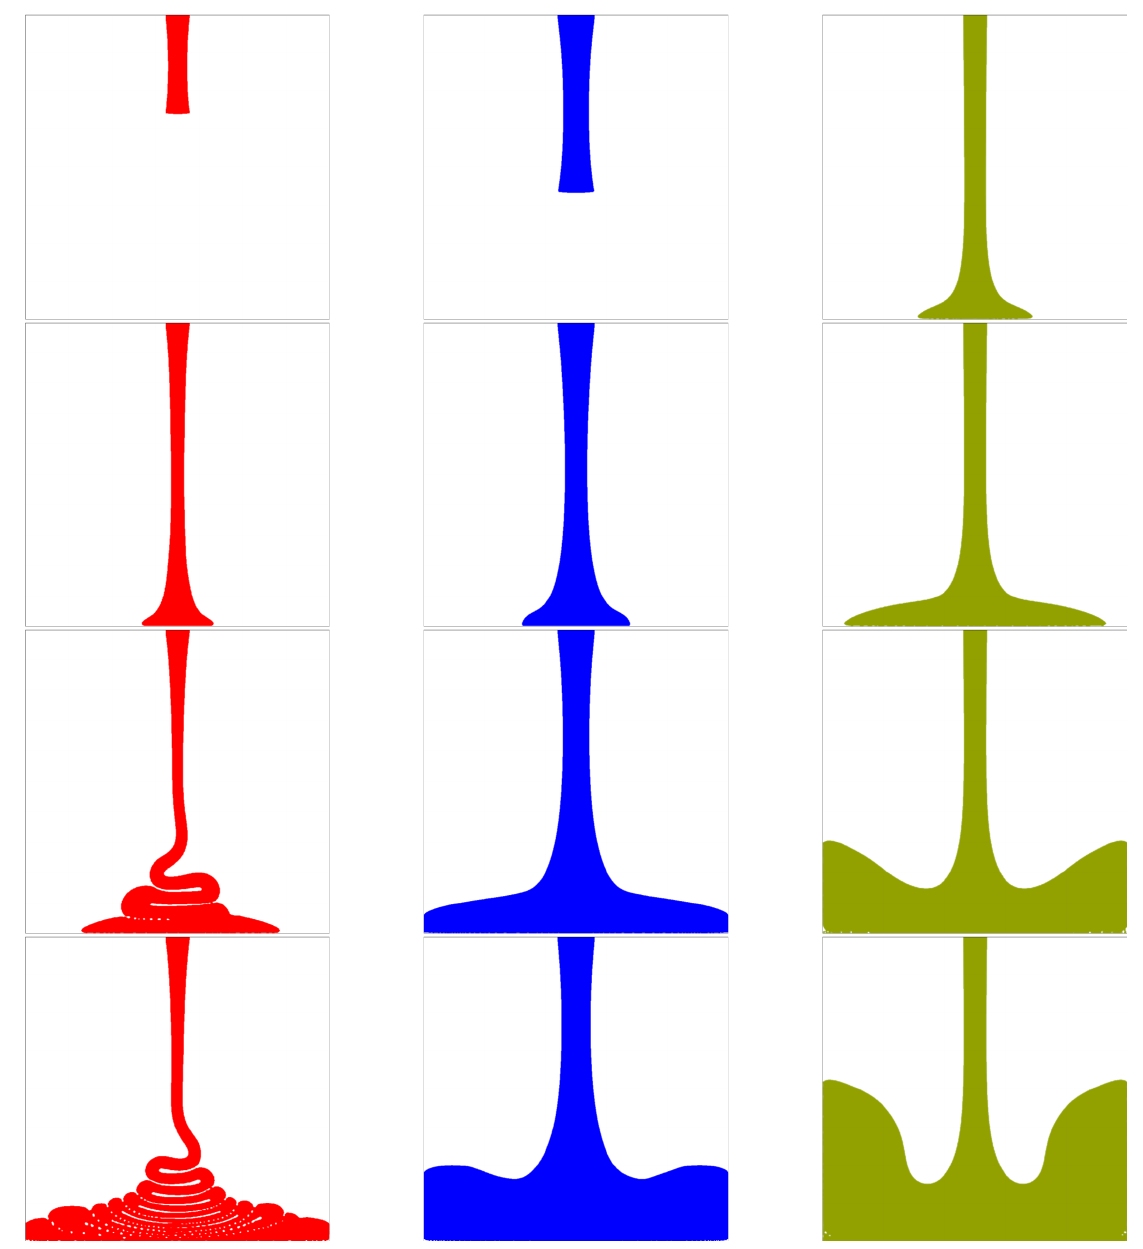
Figure 6. Numerical simulation of a viscous liquid (propergol) jet injected in a square cavity ( 1 m × 1 m ) on a 320 × 320 grid: the interface is plotted at time t = 0.25 s, 0.25 s and 0.2 s (first row), t = 0.75 s, 0.75 s and 0.3 s (second row), t = 1.25 s, 1.25 s and 0.6 s (third row) and t = 2 s, 2 s and 0.9 s (fourth row). First column Re = 0.1728, second column Re = 0.6 and third column Re = 3.6. Simulations are carried out wit hthe FC